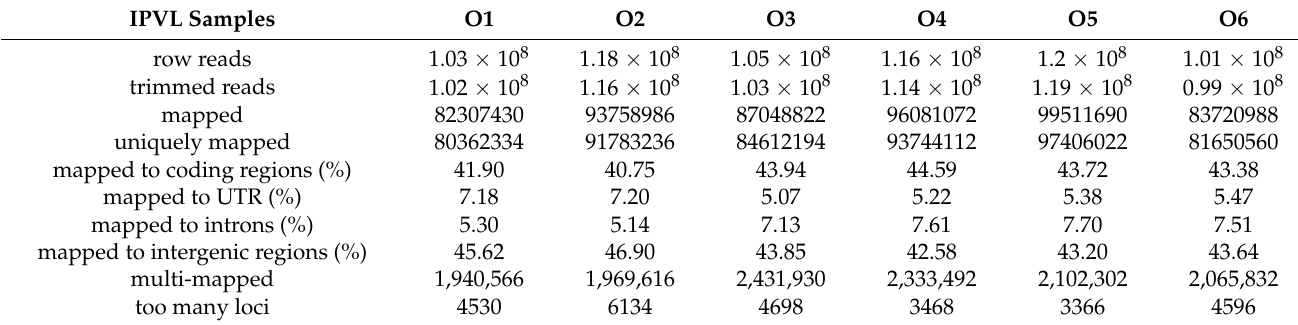
Table 1. Overall Statistics of Sequencing and Mapping Results of Six RNA-Seq Libraries Extracted from the Inner Perivitelline